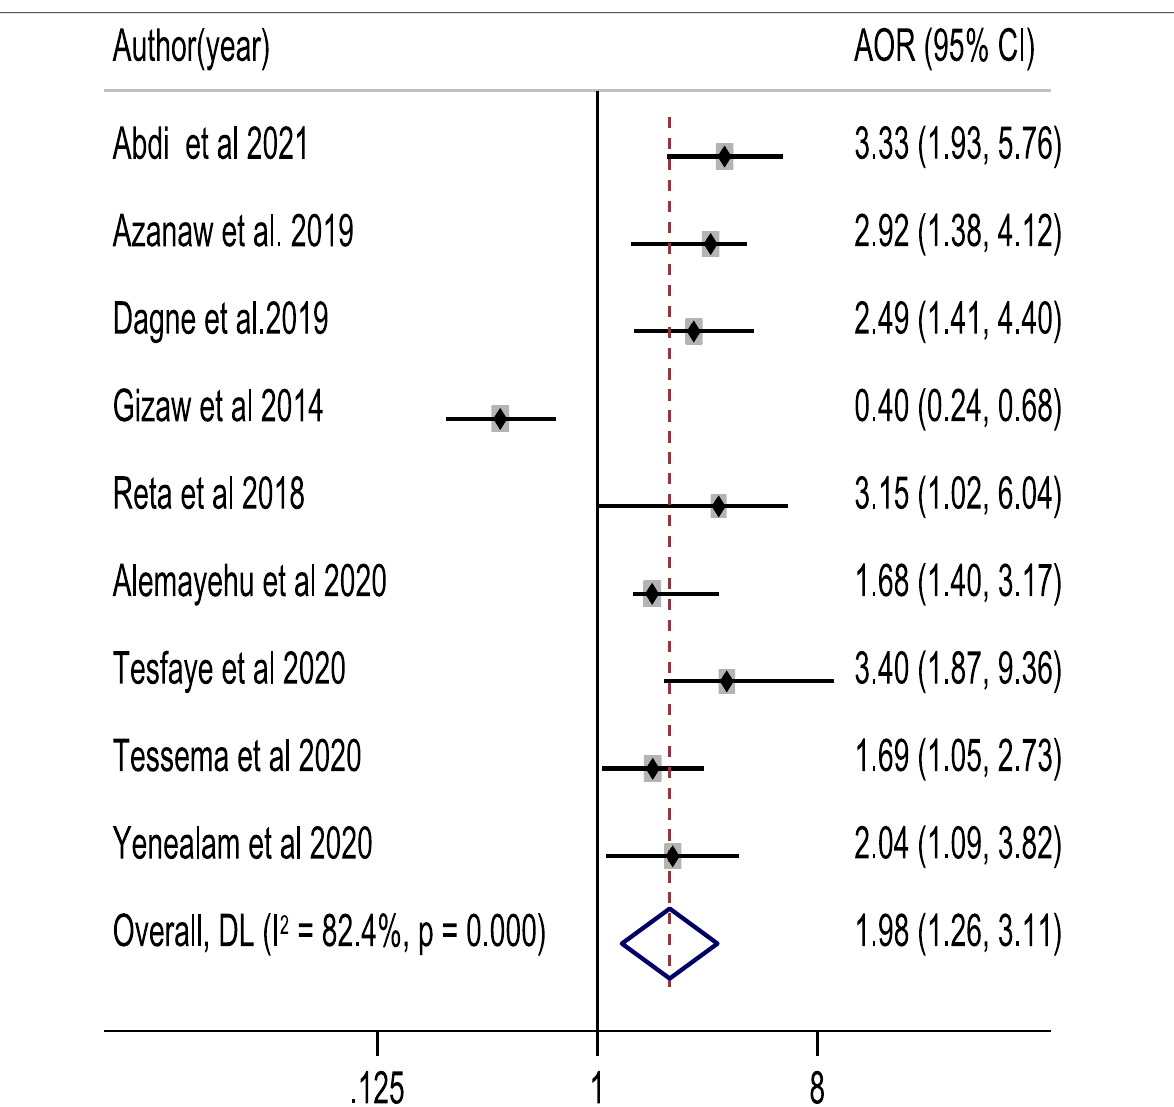
Fig. 5 The pooled adjusted odds ratio of the association between good knowledge of food handlers and food hygiene practice in